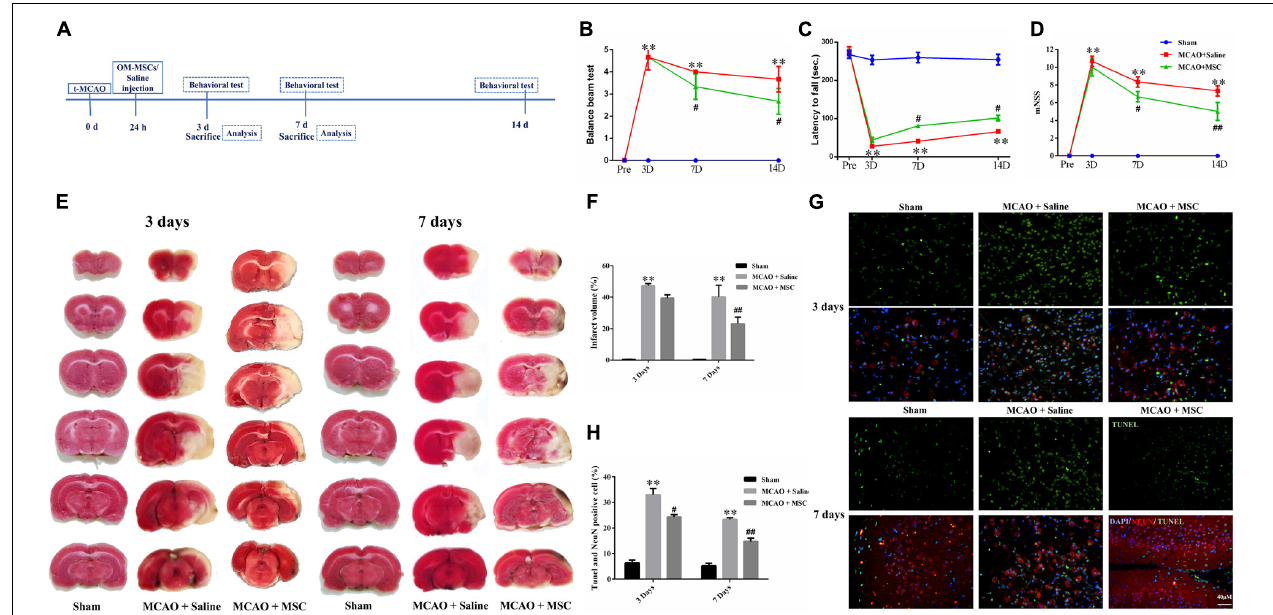
FIGURE 1 | OM-MSCs ameliorated neurological deficit and inhibited neuronal apoptosis in an MCAO animal model. (A) Schematic representation of the experimental design for in vivo experiments. (B) The balance beam test, (C) the rotarod test, and (D) the modified neurological severity score (mNSS) test were performed before MCAO and on 3, 7, and 14 days after MCAO ( n = 7/group at 3 and 7 days; n = 5/group at 14 days). (E,F) The cerebral infarct volume, assessed by TTC staining of coronal brain sections after MCAO ( n = 3). (G) Neuronal apoptosis in the ipsilateral cortex as detected by NeuN and TUNEL immunofluorescence staining after MCAO. (H) Quantification of NeuN and terminal transferase-mediated dUTP nick end labeling (TUNEL) double-stained cells ( n = 3). All data are displayed as mean ± SEM. ( ∗ P < 0.05, ∗∗ P < 0.01 vs. sham-operated, # P < 0.05, ## P < 0.01 vs. MCAO + saline).